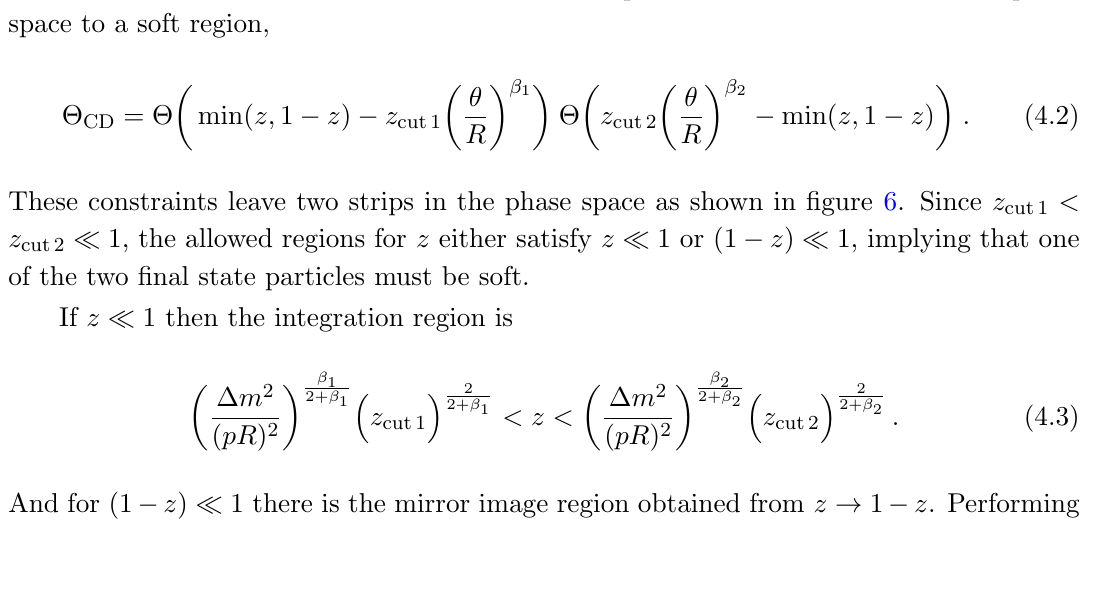
= R and (cid:17) = 0 so that p = p 0 J